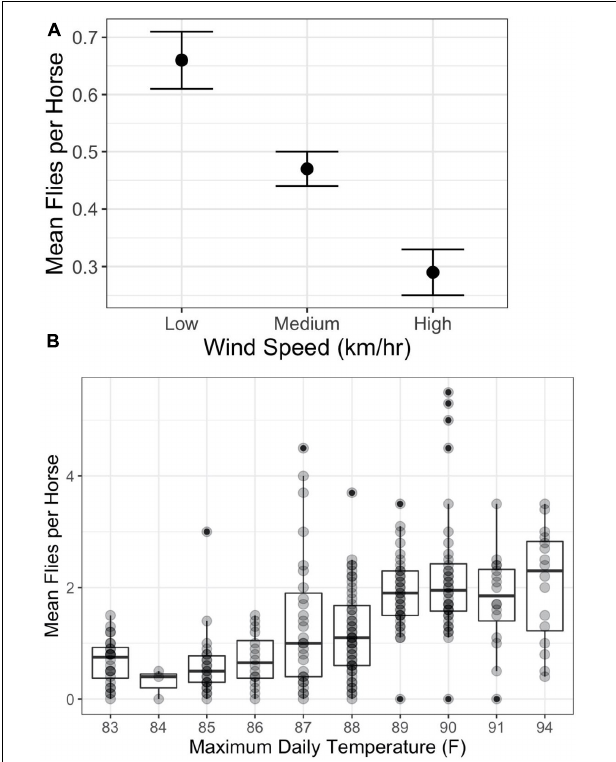
FIGURE 1 | Relationship between per capita fly numbers and environmental factors. (A) Impact of wind speed on per capita numbers (mean and standard error) and wind speed category (Low = 0–5 km/h; Medium = 6–15 km/h; and High > 15 km/h) ( F 2 , 750 = 12.2; p < 0.0001). (B) Impact of daily maximum temperatures on per capita numbers (mean and standard error) ( F 9 , 229 = 11.78; p < 0.0001; R 2 = 0.32). Correlations between maximum temperature and mean daily fly numbers are positive and significant from 83 ◦ F to 89 ◦ F ( F 1 , 169 = 42.17; p < 0.0001; R 2 = 0.20), but level off showing no statistically significant correlation above 89 ◦ F ( F 1 , 99 = 0.01; p < 1; R 2 = 0). Darker points represent multiple occurrences.